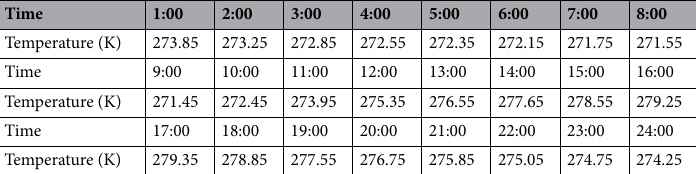
Table 4. Hourly outdoor air